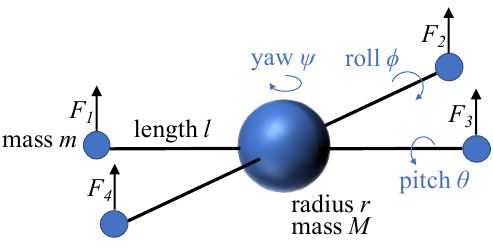
Figure 1. The physical model of a quadcopter